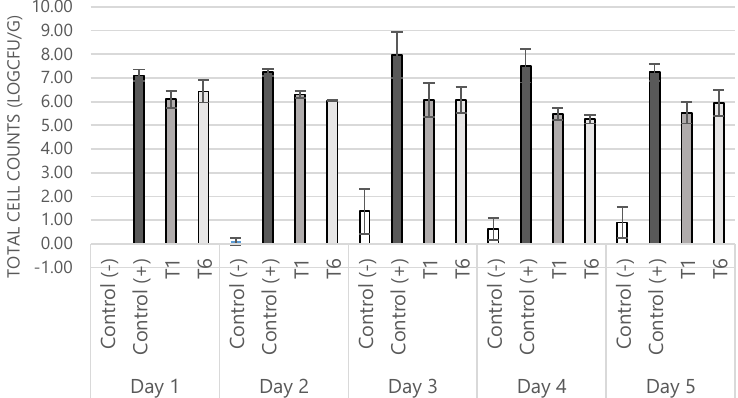
Figure 2. Total cell counts expressed in log CFU/g in the treated and not treated pineapple slides during storage with refrigeration. Legend: Control (−): fruit slices, no pathogens, no peptide; Control (+): fruit slices + indicator cocktail; T1: fruit slices treated with indicator cocktail + formulation T1 (CFS); T6: fruit slices treated with indicator cocktail + formulation T6 (PP); T1: Cys5-4CFS + Gt28CFS:1:1 (v/v); T6: Cys5-4PP + Gt28PP:1:1 (v/v).